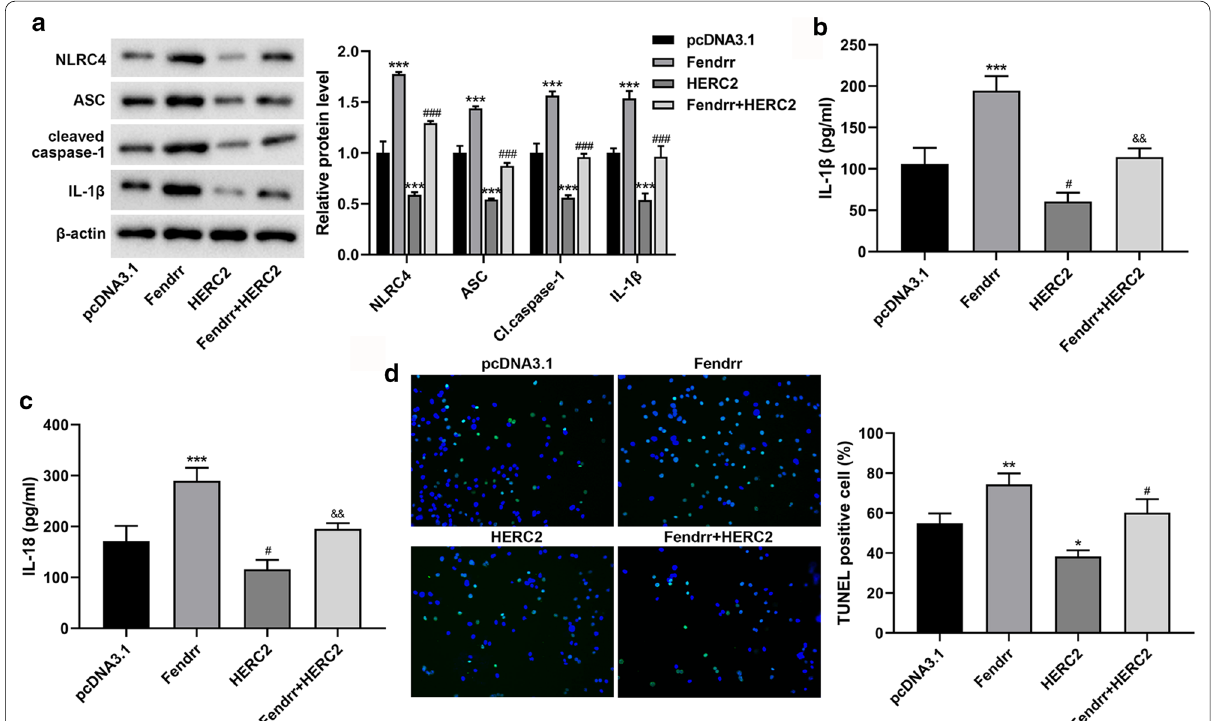
Fig. 4 Fendrr regulates NLRC4‑mediated microglial pyroptosis through HERC2. Exposing mouse BV‑2 cells to high glucose (HG) followed by hypoxia/reoxygenation (H/R), and the cells were transfected or co‑transfected with pcDNA3.1 (control), pcDNA3.1‑Fendrr and pcDNA3.1‑HERC2. The cells were divided into the pcDNA3.1 group, the Fendrr group, the HERC2 group, and the Fendrr cleaved caspase‑1 and IL‑1β proteins were detected by Western blotting. b , c The levels of IL‑1β and IL‑18 in the cell supernatant were measured by ELISA. d TUNEL analysis was performed on the cells. Data are presented as means ** P < 0.01 and *** P < 0.001 versus the pcDNA3.1 group; # P < 0.05 and ### P < 0.001 versus the Fendrr group; && P < 0.01 versus the Fendrr